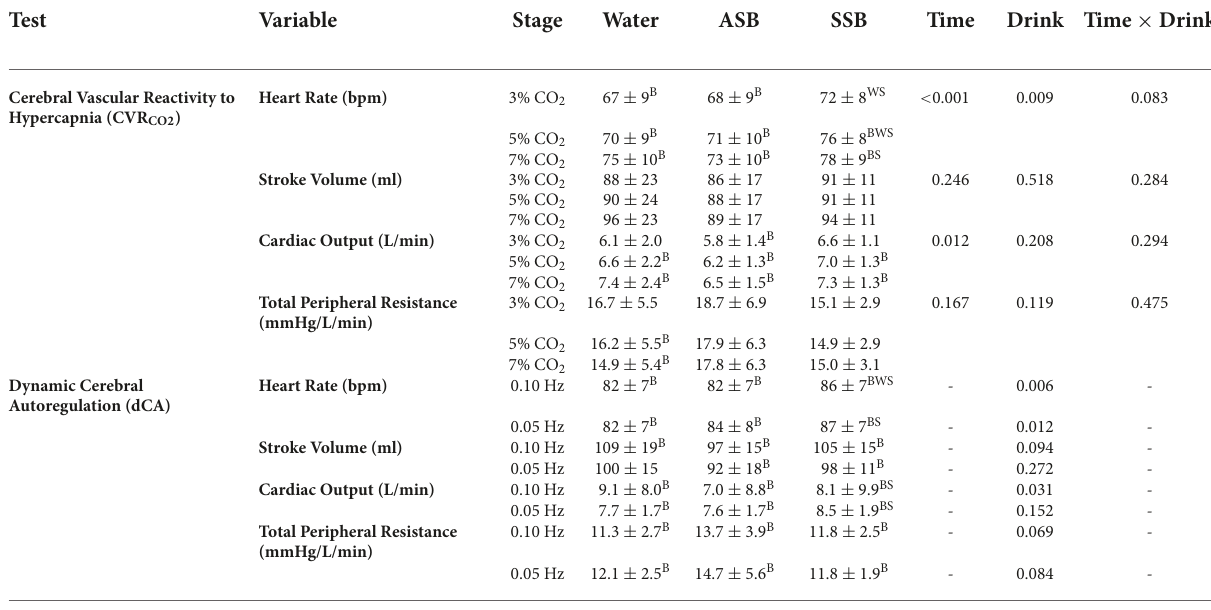
TABLE 2 Cardiovascular responses during each stage of the cerebral vascular reactivity to hypercapnia test and each squat-to-stand frequency of the dynamic cerebral autoregulation tests. Test Variable Stage Water ASB SSB Time Drink Time × Drink